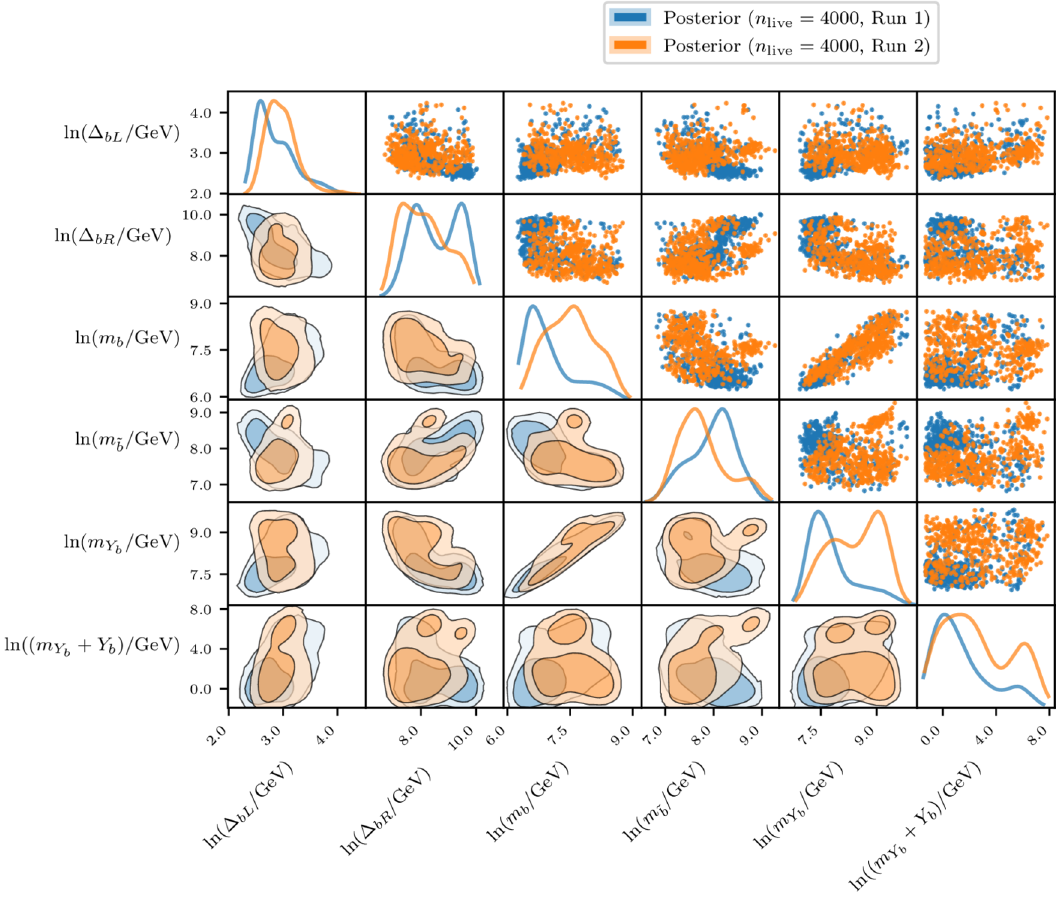
Figure 20. 1D and 2D marginalised posteriors for the bottom partner parameters in the M4DCHM 5 − 5 − 5 found in two different runs with 4000 live